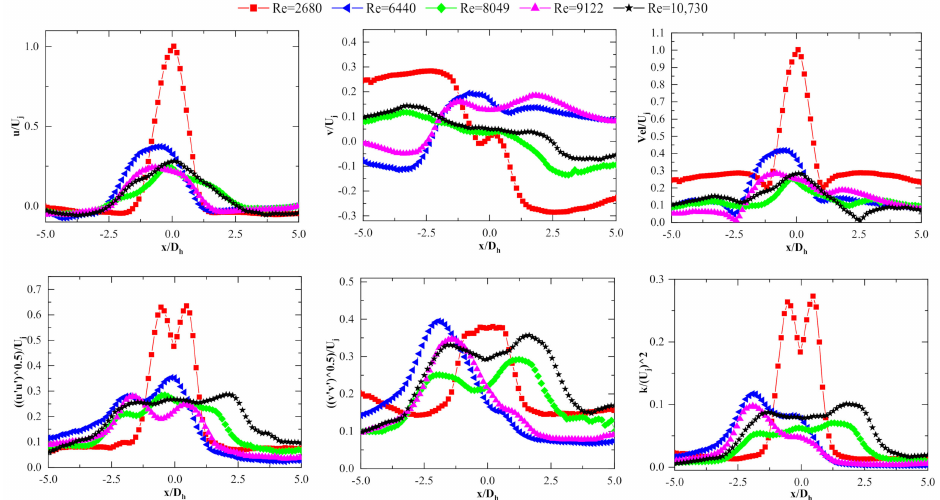
Figure11. Time-averagedvelocitycomponentsandfluctuationsalongy / D h =